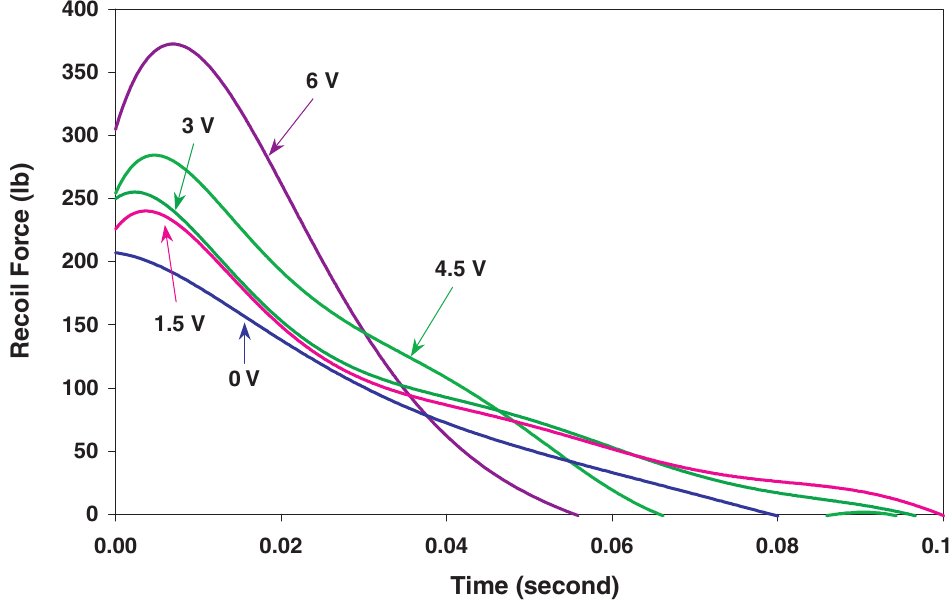
Fig. 8. Recoil force time